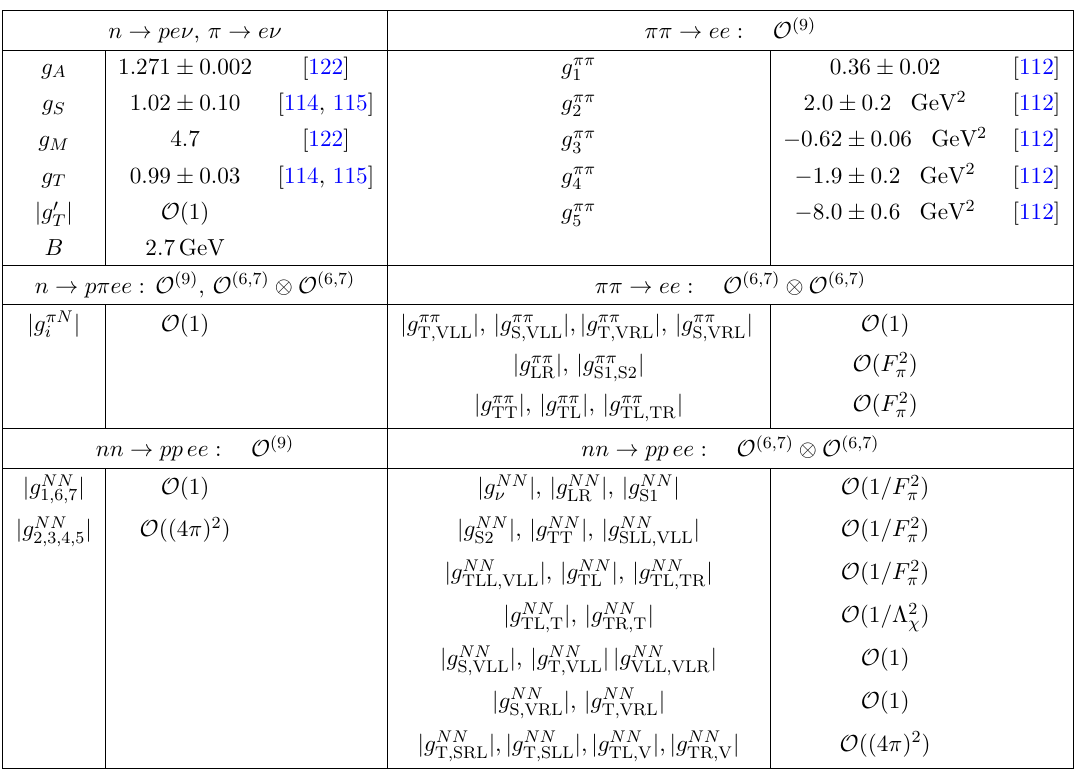
Table 5 . The low-energy constants relevant for the dim-3, dim-6, dim-7, and dim-9 operators. The headings show the type of long-distance ( n ! pe(cid:23) , (cid:25) ! e(cid:23) ) or short-distance processes the LECs induce, while the labels O (9) and O (6 ; 7) (cid:10) O (6 ; 7) indicate whether the corresponding LECs are induced by dim-9 operators or by the insertion of two dim-6(-7) interactions. Whenever known, we quote the values of the LECs at (cid:22) = 2 GeV in the MS scheme.